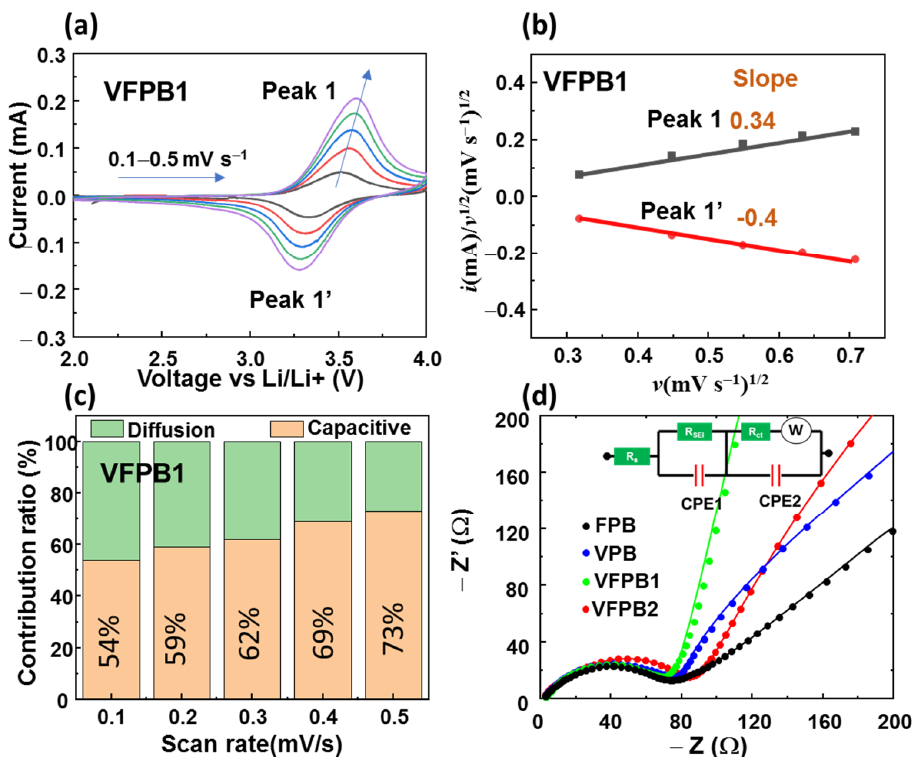
Figure 7. ( a ) CV curves; ( b ) fitted lines of i / v 1/2 vs. v 1/2 at different scan-rate voltages ( v ) from 0.1–0.5 mV s − 1 ; ( c ) capacitance- and diffusion-controlled contribution ratios of the currents of VFPB1 cathodes; and ( d ) Nyquist plots for impedance measurement of FPB, VPB, VFPB1, and VFPB2 cathodes with inset of equivalent circuit.